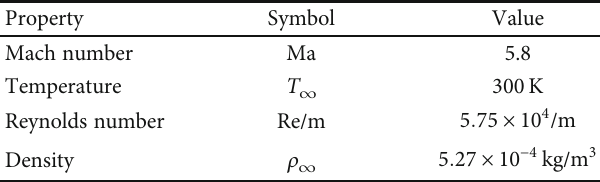
Figure 17: Local grid for scramjet inlet calculations. Table 5: Flow conditions at the scramjet inlet